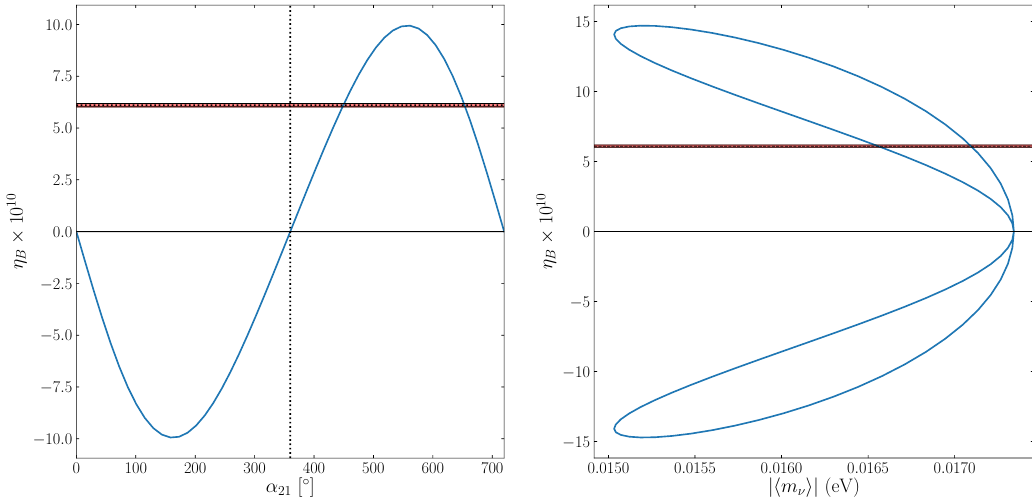
Figure 16 . Leptogenesis at high scales ( M 1 = 3 : 16 10 13 GeV) when CP violation is provided solely (cid:2) by (cid:11) 21 , with (cid:14) = 0 (cid:14) , (cid:11) 31 = 0 (cid:14) . The red bands indicate the 1 (cid:27) observed values for (cid:17) B with the best- (cid:12)t value indicated by the horizontal black dotted lines. Left: the baryon asymmetry as a function of (cid:11) 21 with exact CP -invariance at (cid:11) 21 = 0 (cid:14) and 360 (cid:14) (vertical black dotted lines). Right: the variation of (cid:17) B against parametrically plotted as a function of (cid:11) 21 . Successful leptogenesis m (cid:23) jh ij occurs for (cid:11) 21 449 (cid:14) and (cid:11) 21 653 (cid:14) for which = 0 : 0171 eV and = 0 : 0166 eV m (cid:23) m (cid:23) (cid:25) (cid:25) jh ij jh ij respectively. See text for further details.